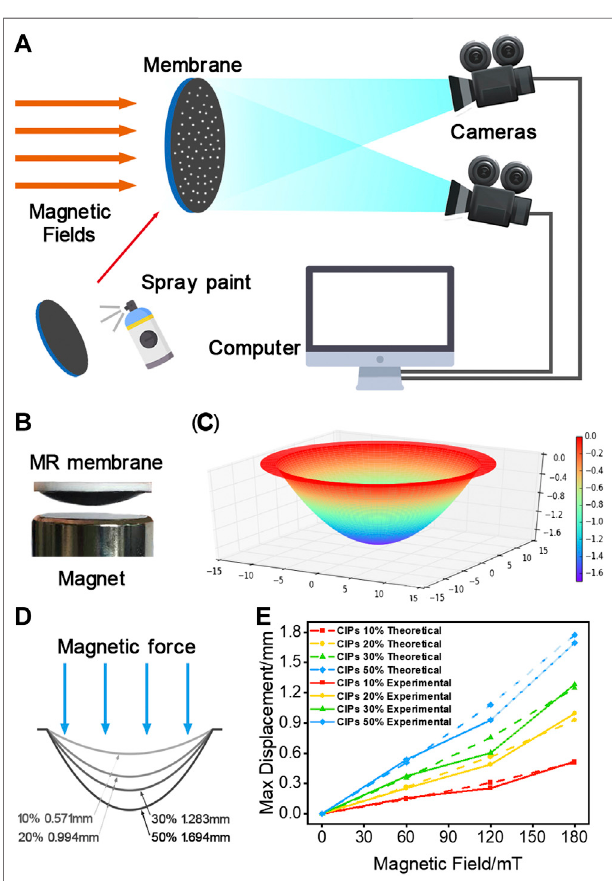
FIGURE4| SchematicdiagramoftheDIC (A) .DeformationoftheMRMs under a magnetic fi eld (B) . Simulation result (C) and deformation diagram (D) of MRMs. Comparison of experimental and theoretical results for the max off- plane displacements (E)